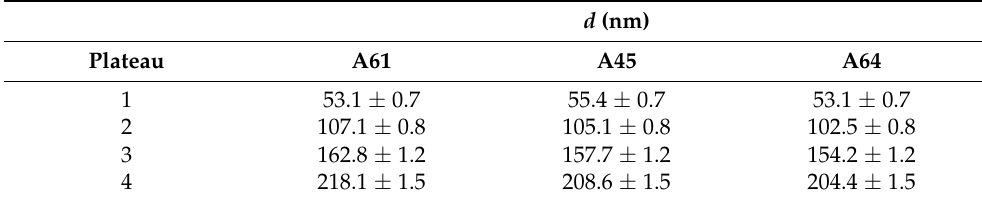
Table 1. Thickness values d (nm) and corresponding standard deviations measured for the different plateaus of A45, A61, A64